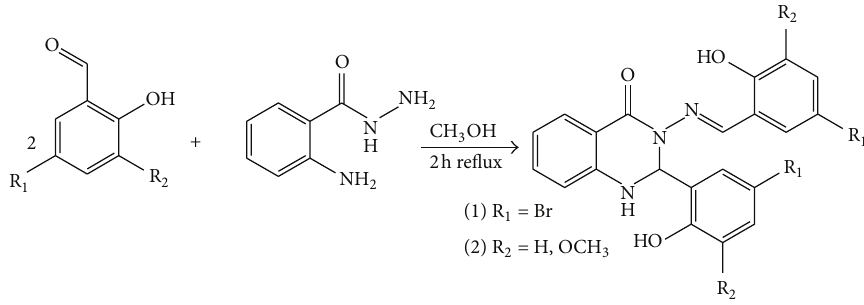
Figure 2: The reaction pathway for the synthesis of compounds (1) and (2).